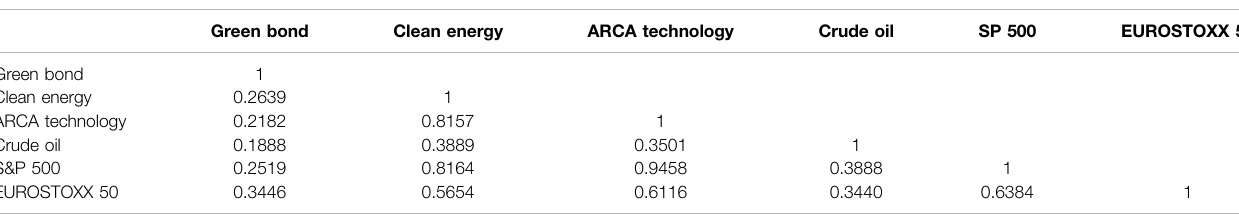
TABLE 2 | Unconditional correlation of daily